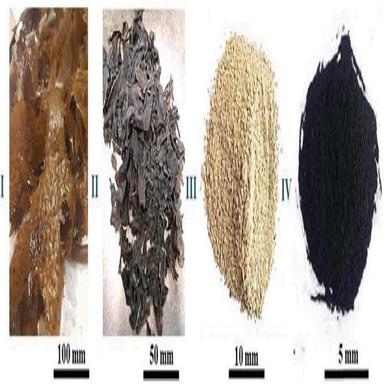
Ecklonia preparation stages: (I) washed raw sample, (II) coarse brittle fragments after 24 h oven drying cycle, (III) micronized and homogenized fines, (IV) biocarbon fine powder after high-T heat treatment.